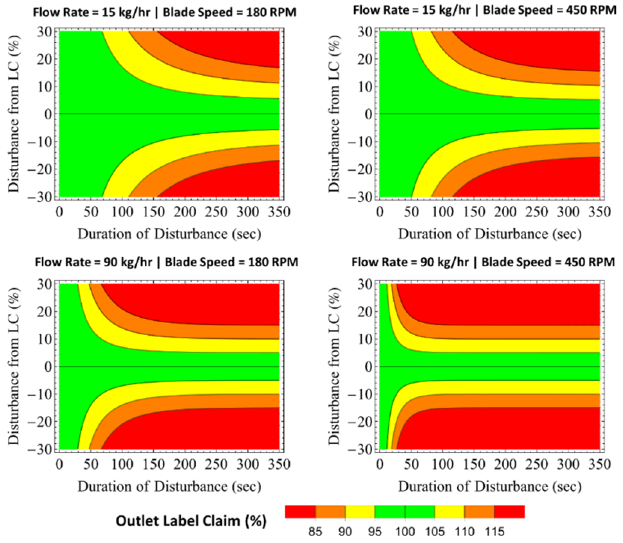
Figure 12. Funnel plots for Blender 1 at various flow rate and blade speed conditions.